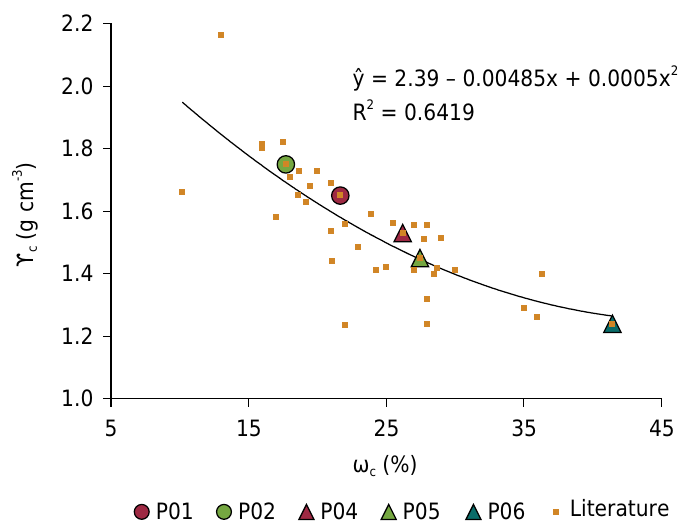
Figure 7. Relationship between optimum compaction moisture (ѡ c ) and a maximum apparent density (ϒ c ) of Vertisols in Bahia State, in comparison to values recorded for expansive soils mentioned in the literature (Table 9).